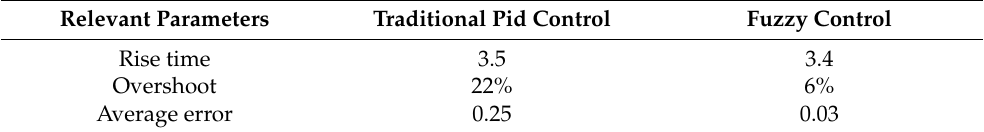
Table 4. Comparison of the parameters of the traditional PID control and fuzzy control step re- sponses.